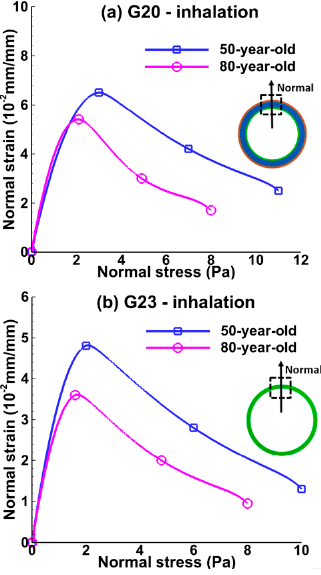
Figure 8. Relationship between normal strain and normal stress during the mid ‐ point of inhalation (t = 0.2 s) at ( a ) the bronchiole (G20) and ( b ) the alveolar sac (G23) tissue for the 50 ‐ year ‐ old and the 80 ‐ year ‐ old.